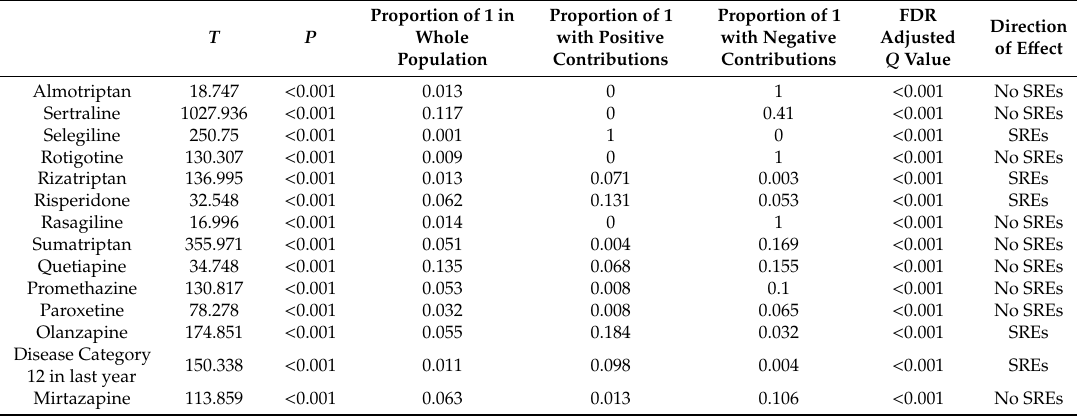
Table A3. Distribution of all categorical